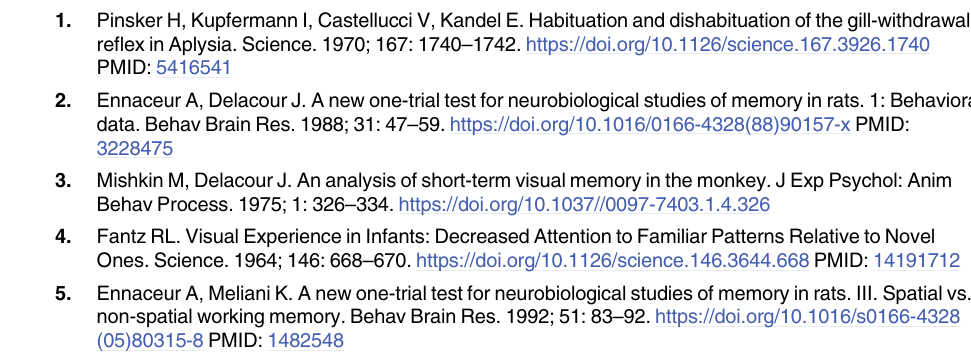
S1 Fig. Apparatus of black context (A), white context (B), and objects (C) used in the experi- ments. S2 Fig. Correlations between exploration time in sample phase and discrimination index in test phase for the object-place-context (A), place (B), object (C) recognition